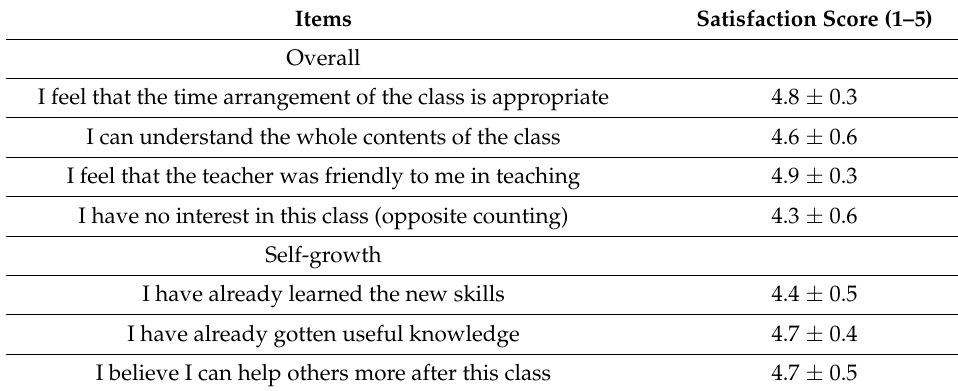
Table 3. The satisfaction of the training course for trainees ( n = 13, 22